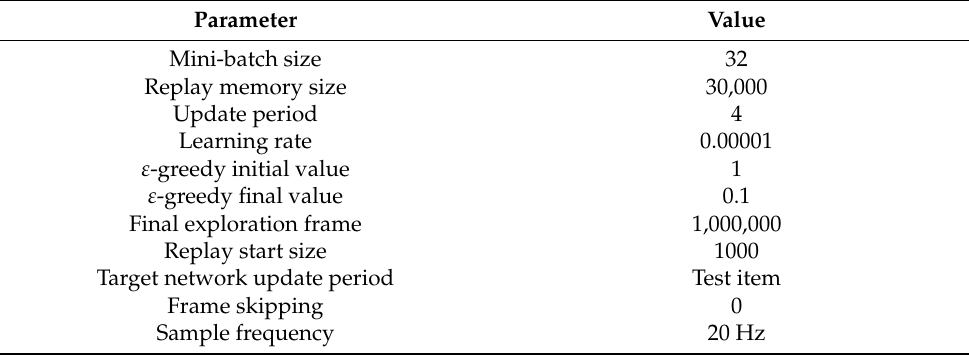
Table 13. The parameters for testing target network update period.